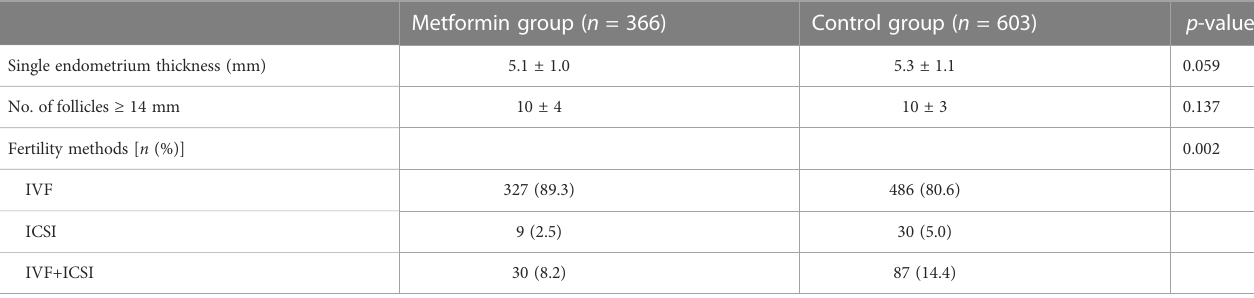
Table 2. After adjusting for age, BMI, duration of infertility, history of OC treatment, AMH, basal FSH, basal LH, FAI, HCY, and TG, as